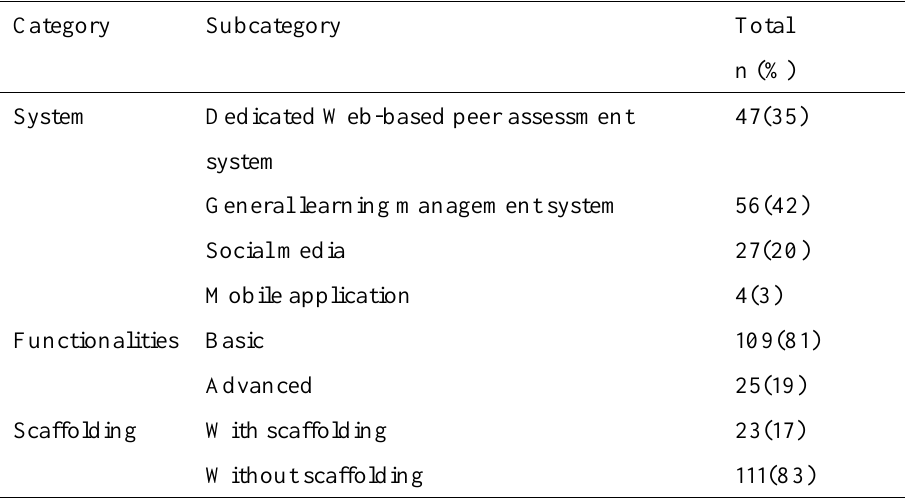
Descriptive Data for the Peer Assessment Tools